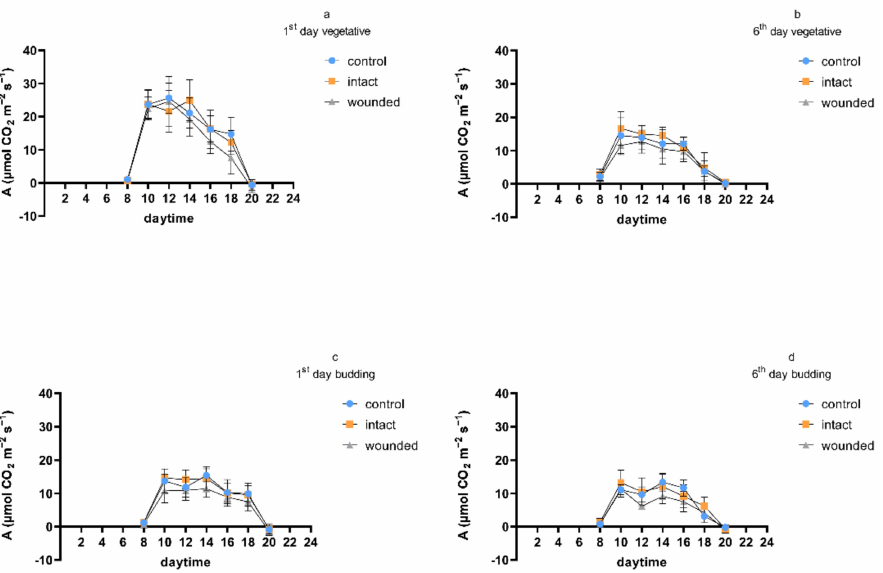
Figure 2. Diurnal photosynthetic rate of Ocimum basilicum var. minimum L.: one ( a , c ) or six ( b , d ) days after leaf wounding imposed at the vegetative ( a , b ) or budding ( c , d ) stage. Data are means ( n = 7) ± standard deviation